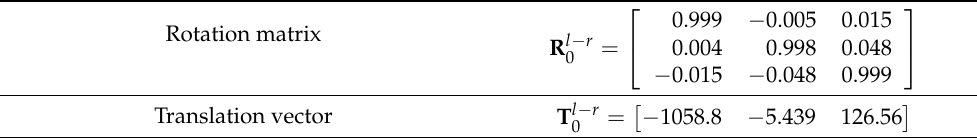
Table 1. The extrinsic parameters at the initial position.